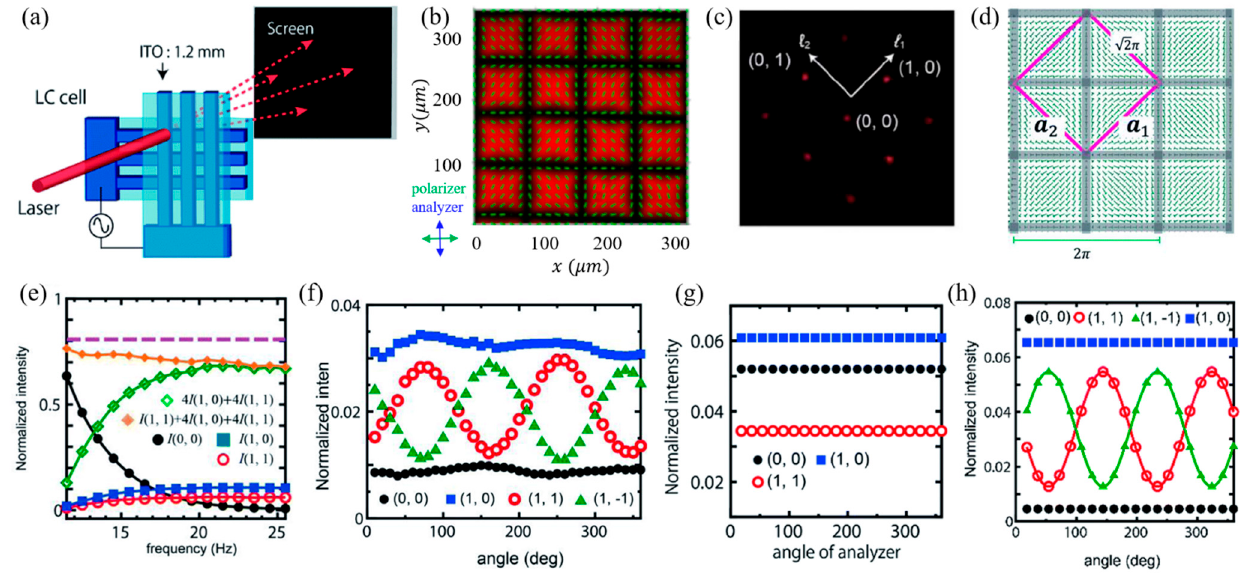
Figure 12. ( a ) Schematic illustration of the LC sample with a micro-pixelated electric field. ( b ) The LC texture observed by POM with an illustration of the 2D LC director orientations. ( c ) The diffraction pattern of a CP incident beam with an applied 25-V 18.5 HZ ac voltage. The diffraction order is labeled based on the primitive cell vector of ( d ). ( d ) LC director orientation of unevenly tilted LC with umbilical defects. The normalized intensity of each diffraction spot observed in the experiment as a function of ( e ) the frequency with a fixed voltage and ( f ) the analyzer angle with a CP incident light. Simulated diffraction intensity as a function of the analyzer angle with a CP incident light, where the LC is assumed to have ( g ) planar alignment, as shown in ( b ), and ( h ) unevenly tilted alignment, as shown in ( d ). ( a , c–g ) Reproduced from Reference [57] with permission from the Royal Society of Chemistry. ( b ) Reproduced with permission from Reference [56] Copyright (2018) by the American Physical